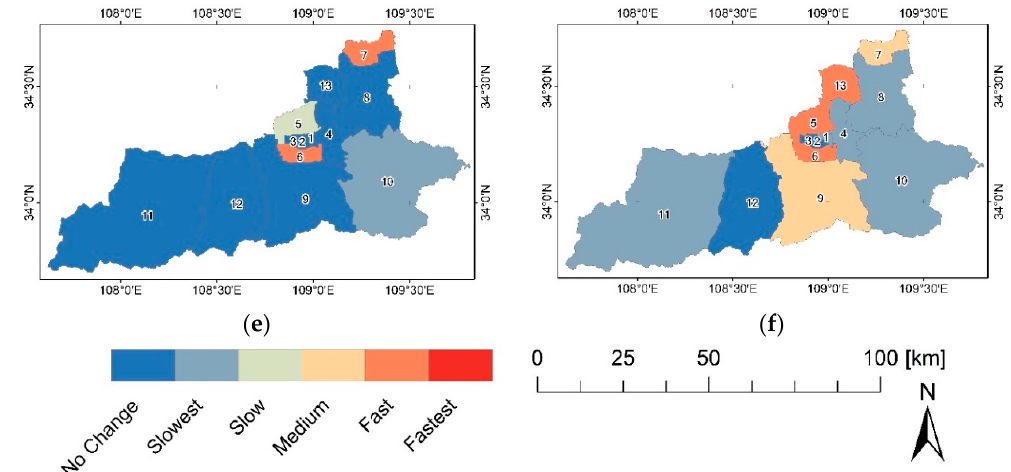
Figure 4. Spatial variation of the land urbanization intensity index (LUII) on the county / district level in Xi’an for the period 1980–2015. The LUII values (% per year) were categorized into six classes (No change: 0% / year, Slowest: > 0–0.1% / year, Slow: > 0.1–0.3% / year, Medium: 0.3–0.6% / year,